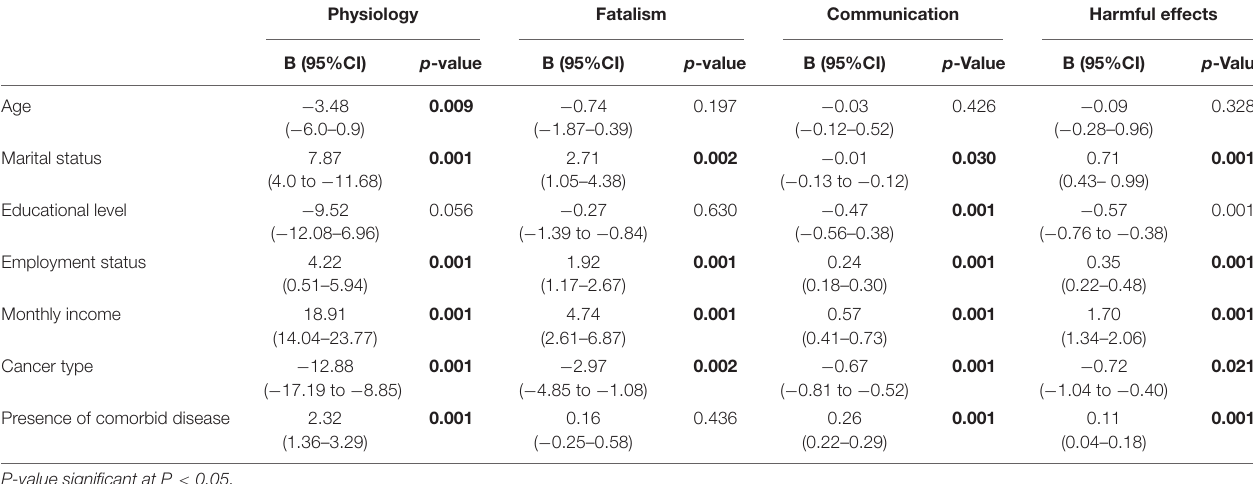
TABLE 5 | Predictors associated with attitudinal barriers to pain management of male cancer patients.